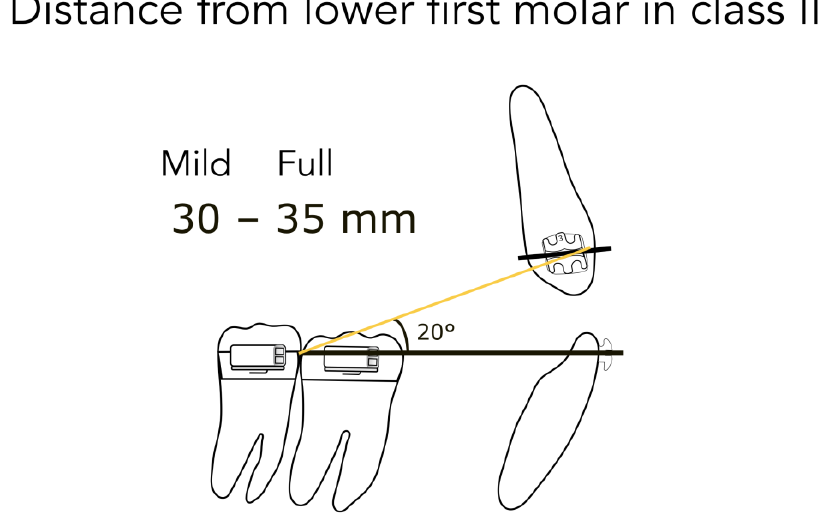
Figure 6. Distance from the lower first molar in Class II.